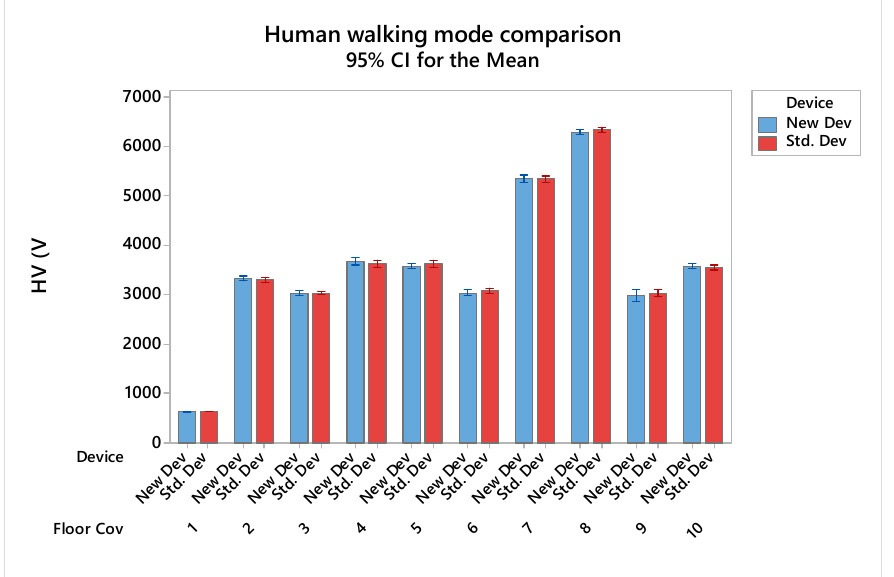
Figure 9. Highest valleys (V) with quality of floorcoverings and platform (New, Std.) as X variable to show the difference of means and Standard deviation as interval.